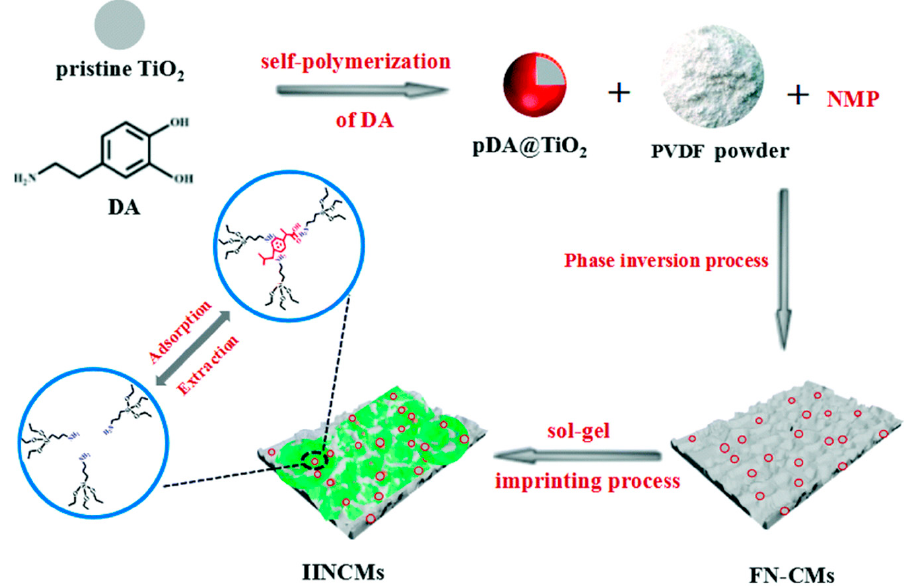
Figure 14. Schematic illustration of the procedures used to construct imprinted nanocomposite membranes with pDA@TiO2 microspheres for the selective recognition of ibuprofen. Reproduced with permission from [56].